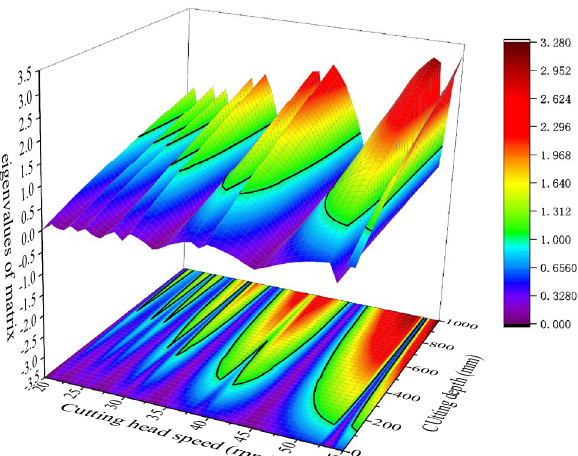
Figure 7. Eigenvalue calculation results of state transition